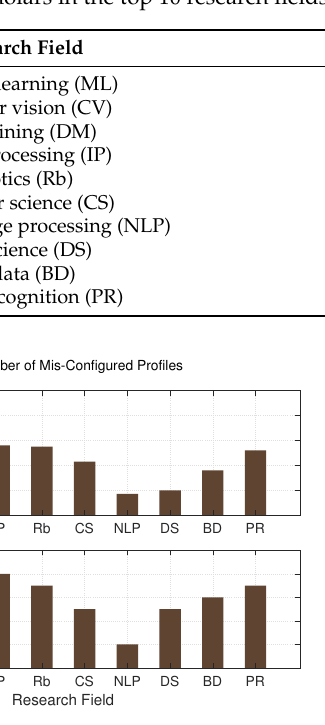
Figure 3. Number of outstanding scholars’ mis-configured author profiles. The upper histogram is the number of mis-configured author profiles in the first 10 searching result pages and the lower histogram is that in the first searching result page. The abbreviations of research fields are the same as Table 6.